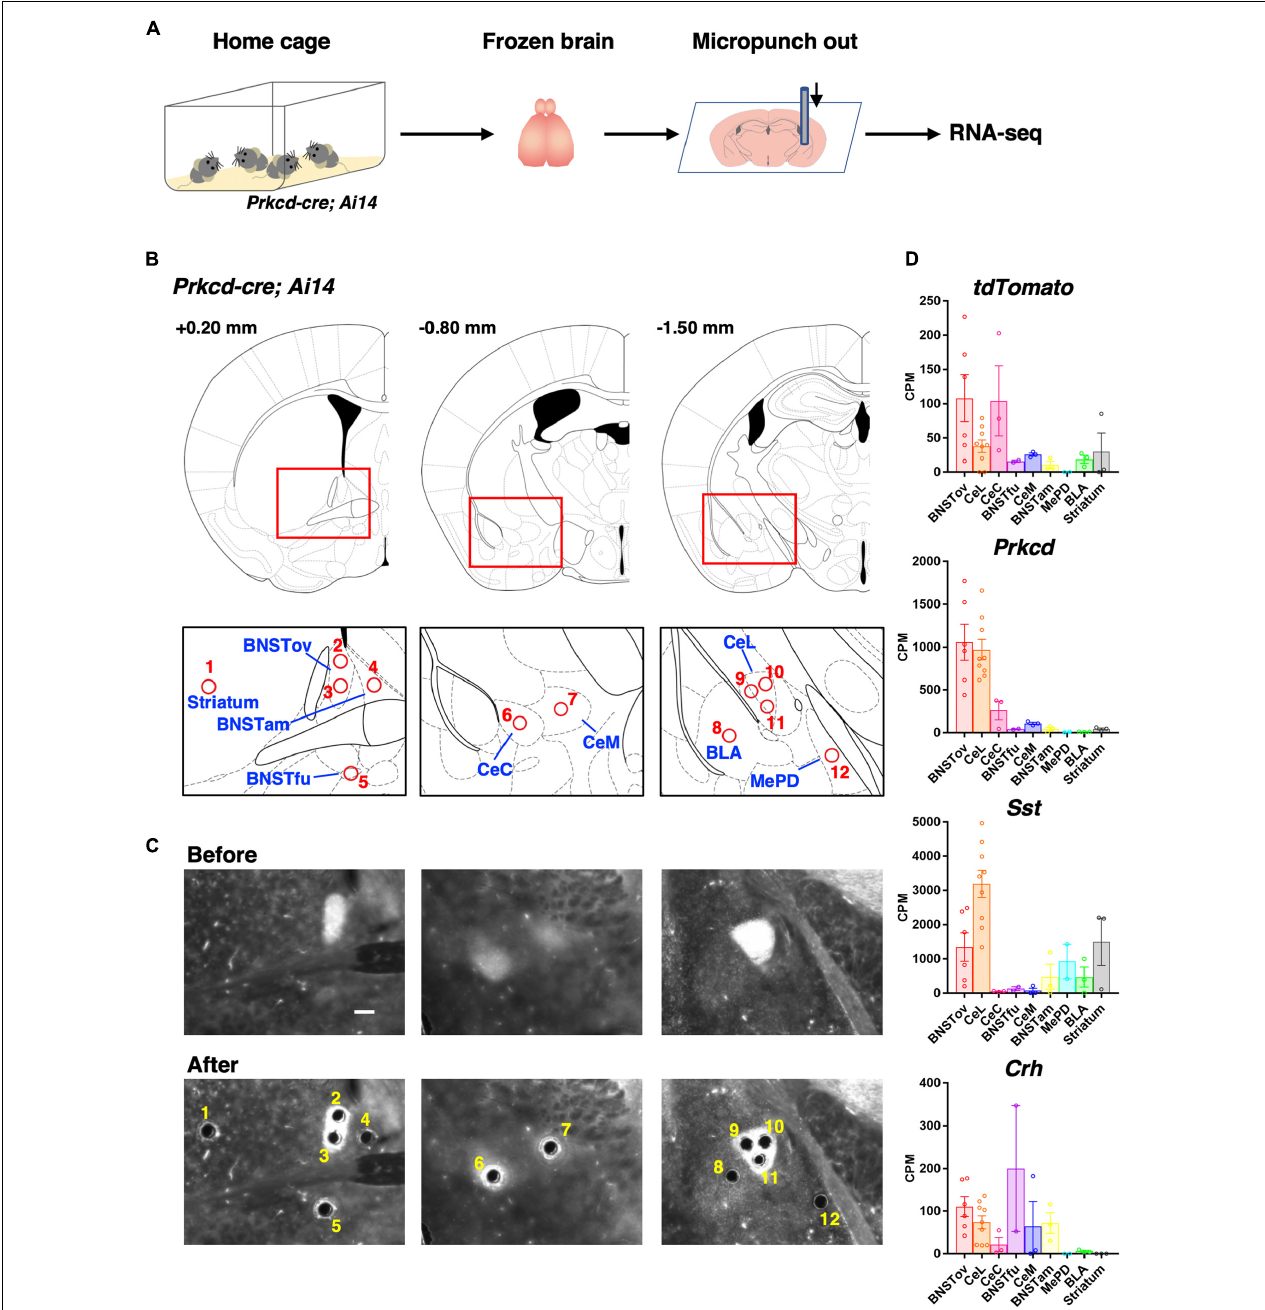
FIGURE 3 | Subnuclei-targeted microtissue collection for RNA-seq. (A) Schematic diagram of tissue collection and RNA-seq. (B) Schematic brain atlas illustrations of 12 collection points from nine brain regions (1, striatum; 2, 3, BNSTov; 4, BNSTam; 5, BNSTfu; 6, CeC; 7, CeM; 8, BLA; 9–11, CeL; and 12, MePD). Numbers indicate anterior-posterior distances from bregma. (C) Representative images of the tdTomato expression of Prkcd-cre; Ai14 mouse brain sections on polyphenylene sulfide films before (upper) and after (lower) punch out corresponding to (B) . Scale bar, 200 µ m. (D) Expression levels of tdTomato and CeL marker genes in nine brain regions represented by counts per million (CPM)